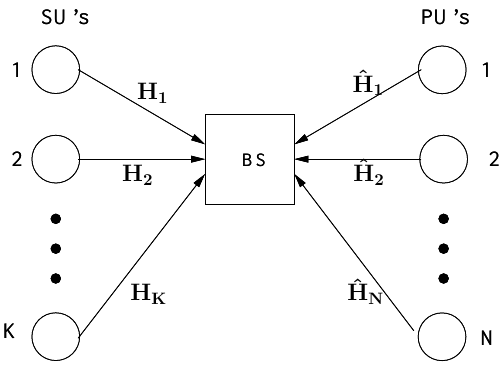
Figure 1. Cognitive radio (CR)-MIMO-MAC system